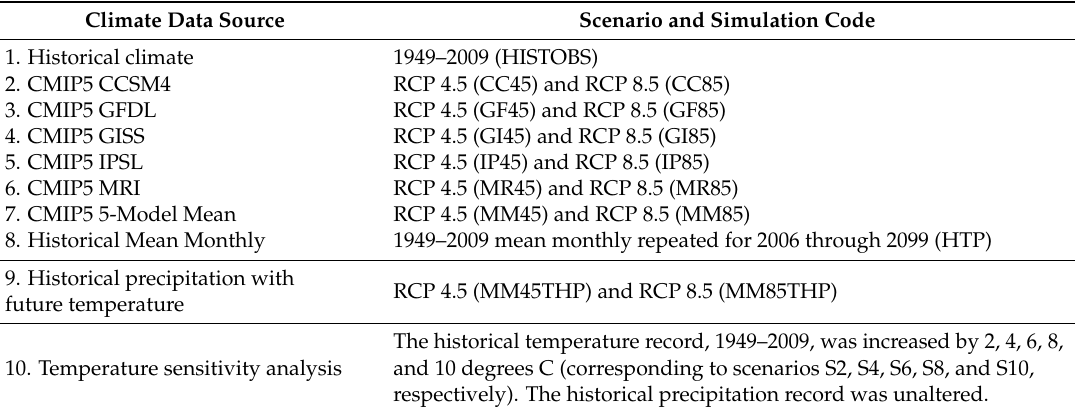
Table 2. Model simulations performed.